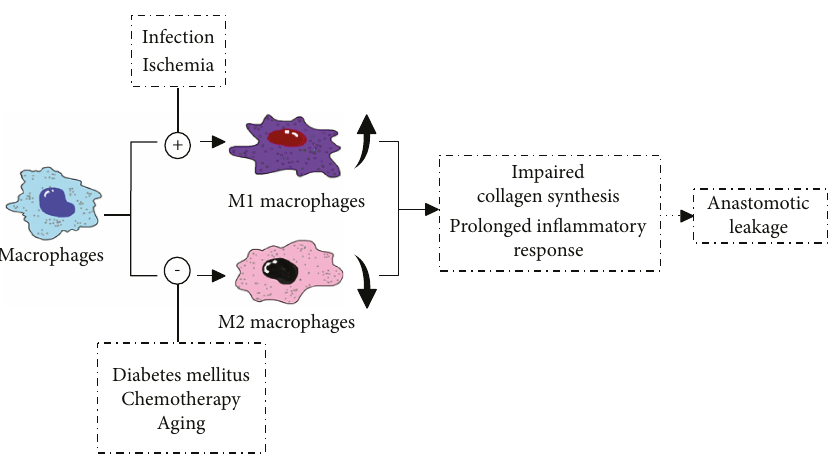
Figure 2: Imbalance of polarized macrophages contributes to the occurrence of anastomotic leakage. In some pathological conditions (infection, ischemia, diabetes mellitus, etc.), macrophages are abnormally activated into M1-type macrophages or inhibited to express the M2-type phenotype, which leads to long-time in fl ammatory response in the anastomotic site and in fl uences collagen deposition and tissue repair; all of those are thought to be associated with anastomotic